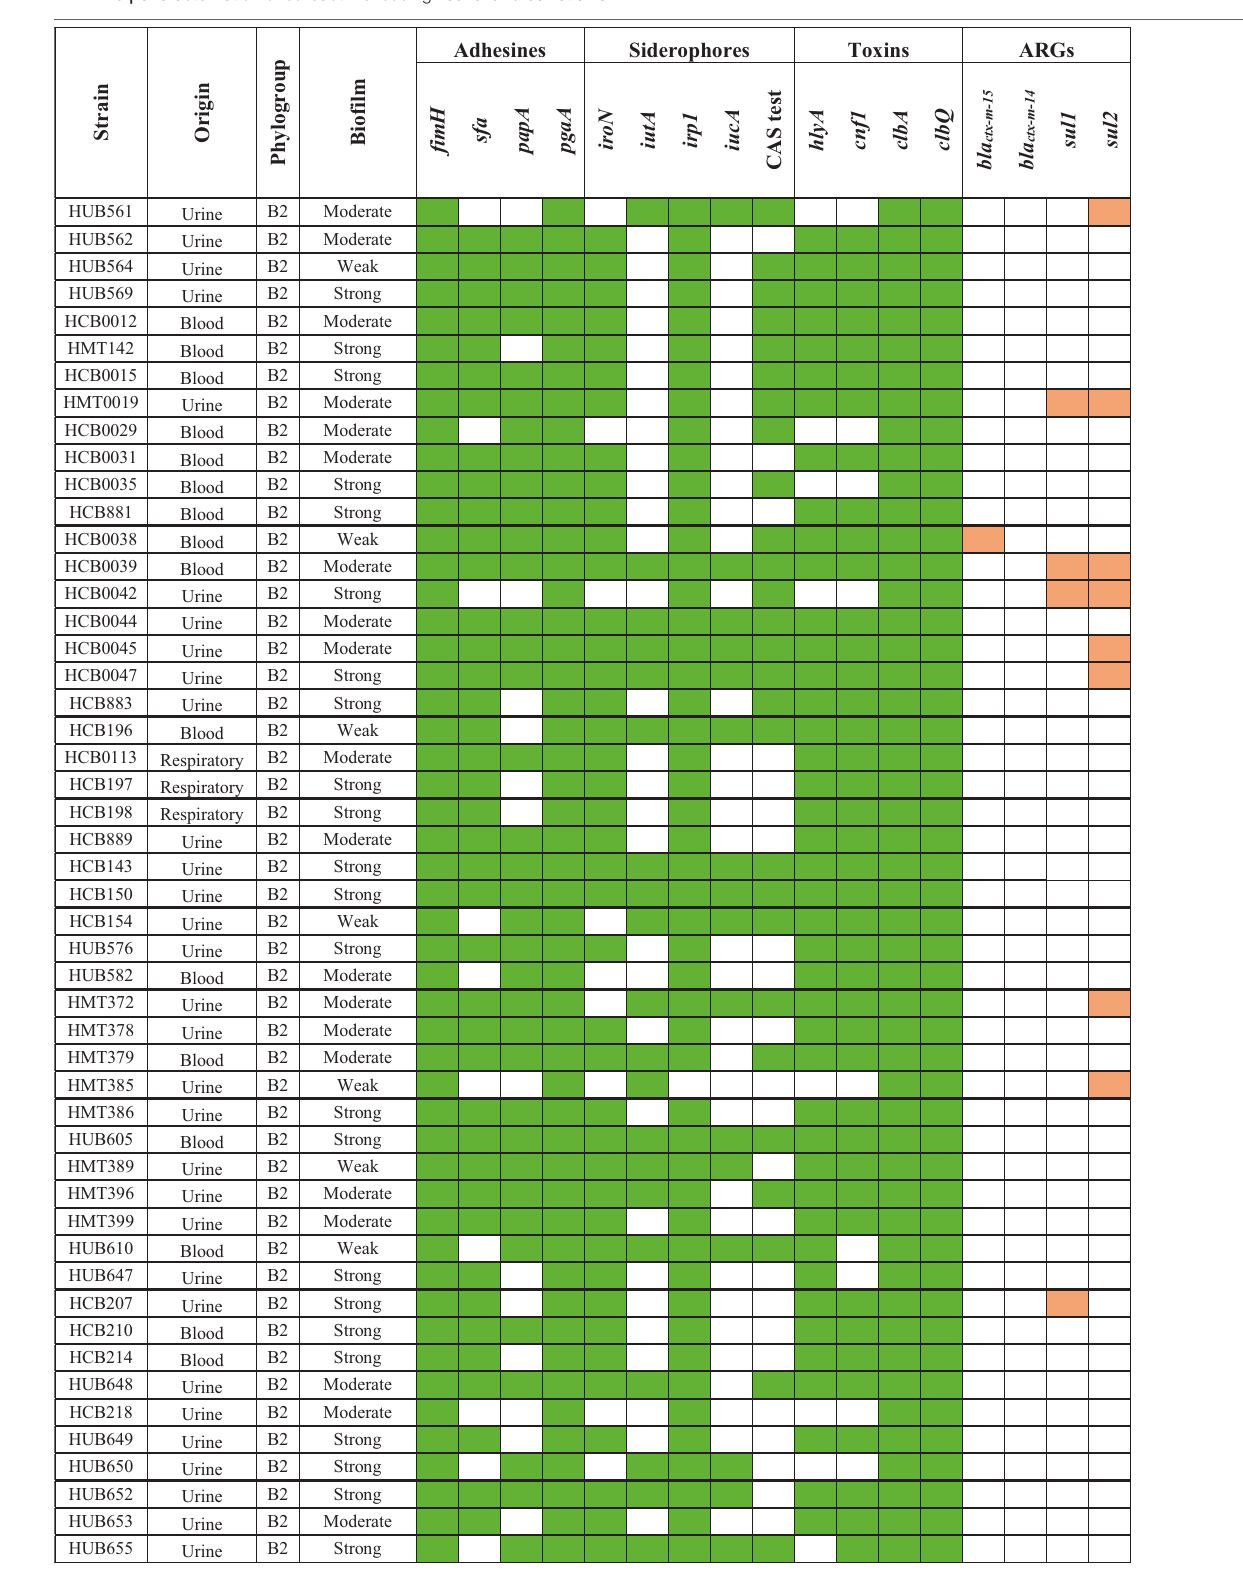
TABLE 3 | Characterization of colibactin-encoding Escherichia coli strains.